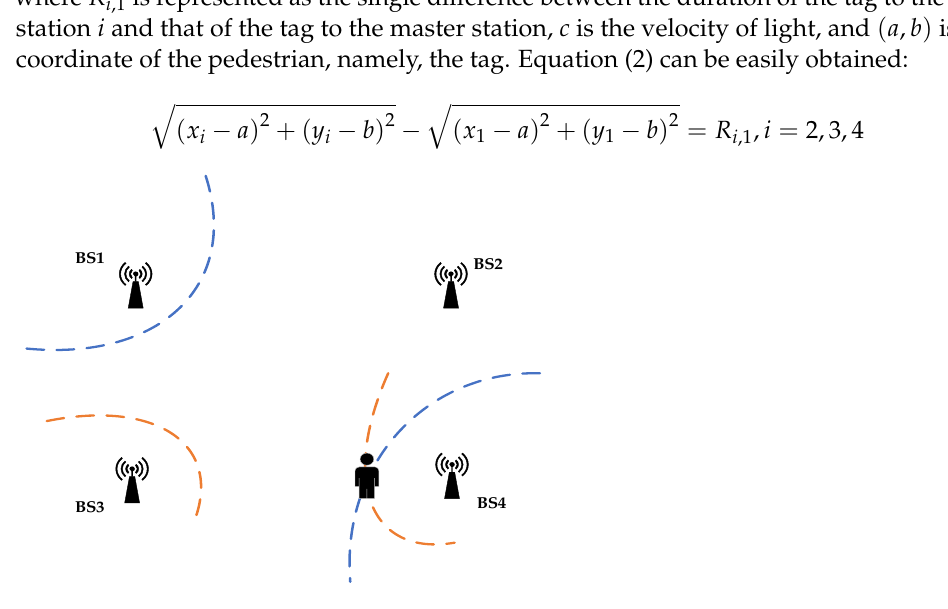
Figure 1. TDOA positioning schematic diagram.